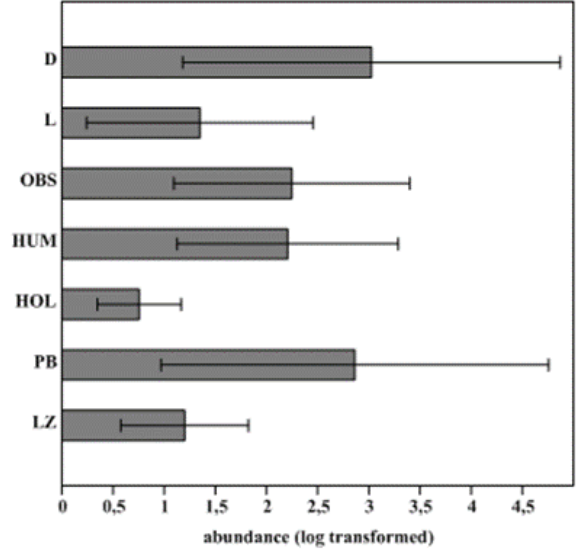
Figure 4. Differences in the species richness (log transformed ± SE) of Coleoptera assemblages. Habitat symbols: LZ = lagg zone; PB = pine bog; HOL = hollow; HUM = hummock; OBS = open bog space; L = lakeshore; D = dome.